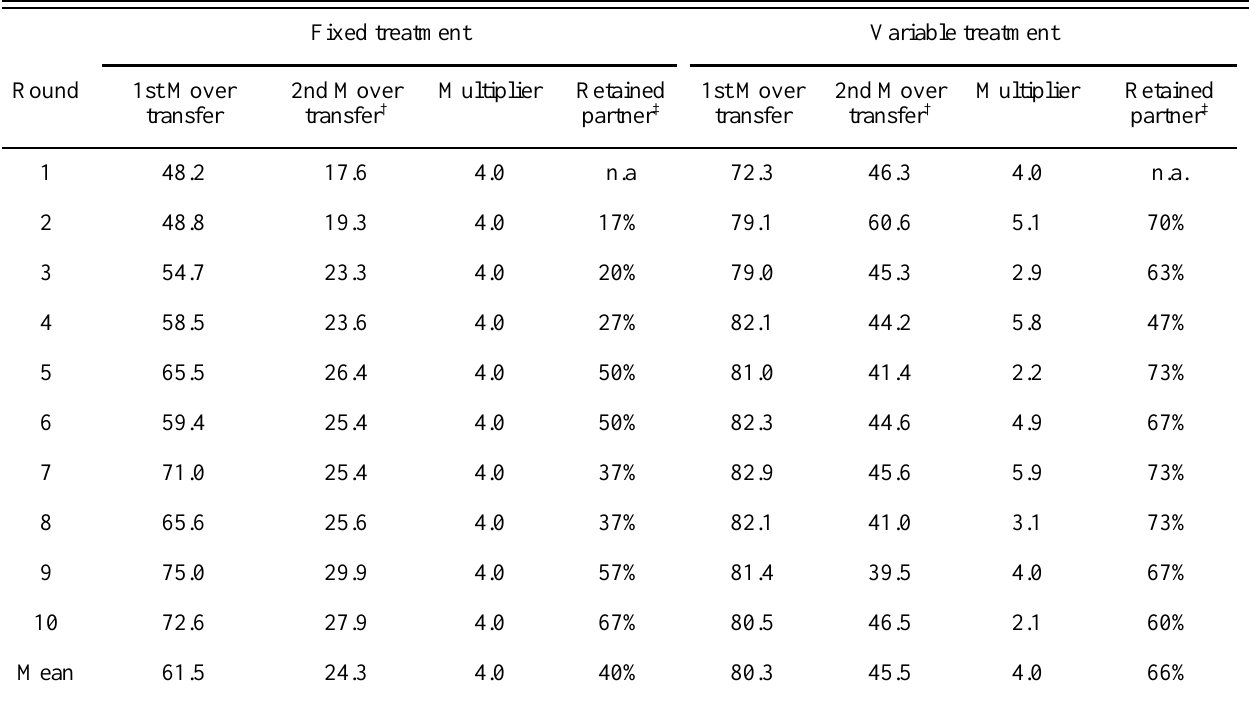
Table 2. Mean behavior over 10 rounds. Fixed treatment Variable